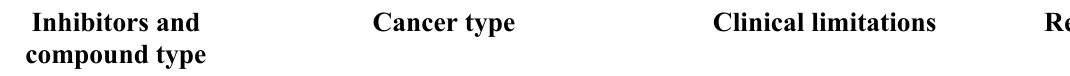
Table 1. Some selected HDAC inhibitors that have been used successfully in cancer treatment and side effect in patients exposed to these HDAC